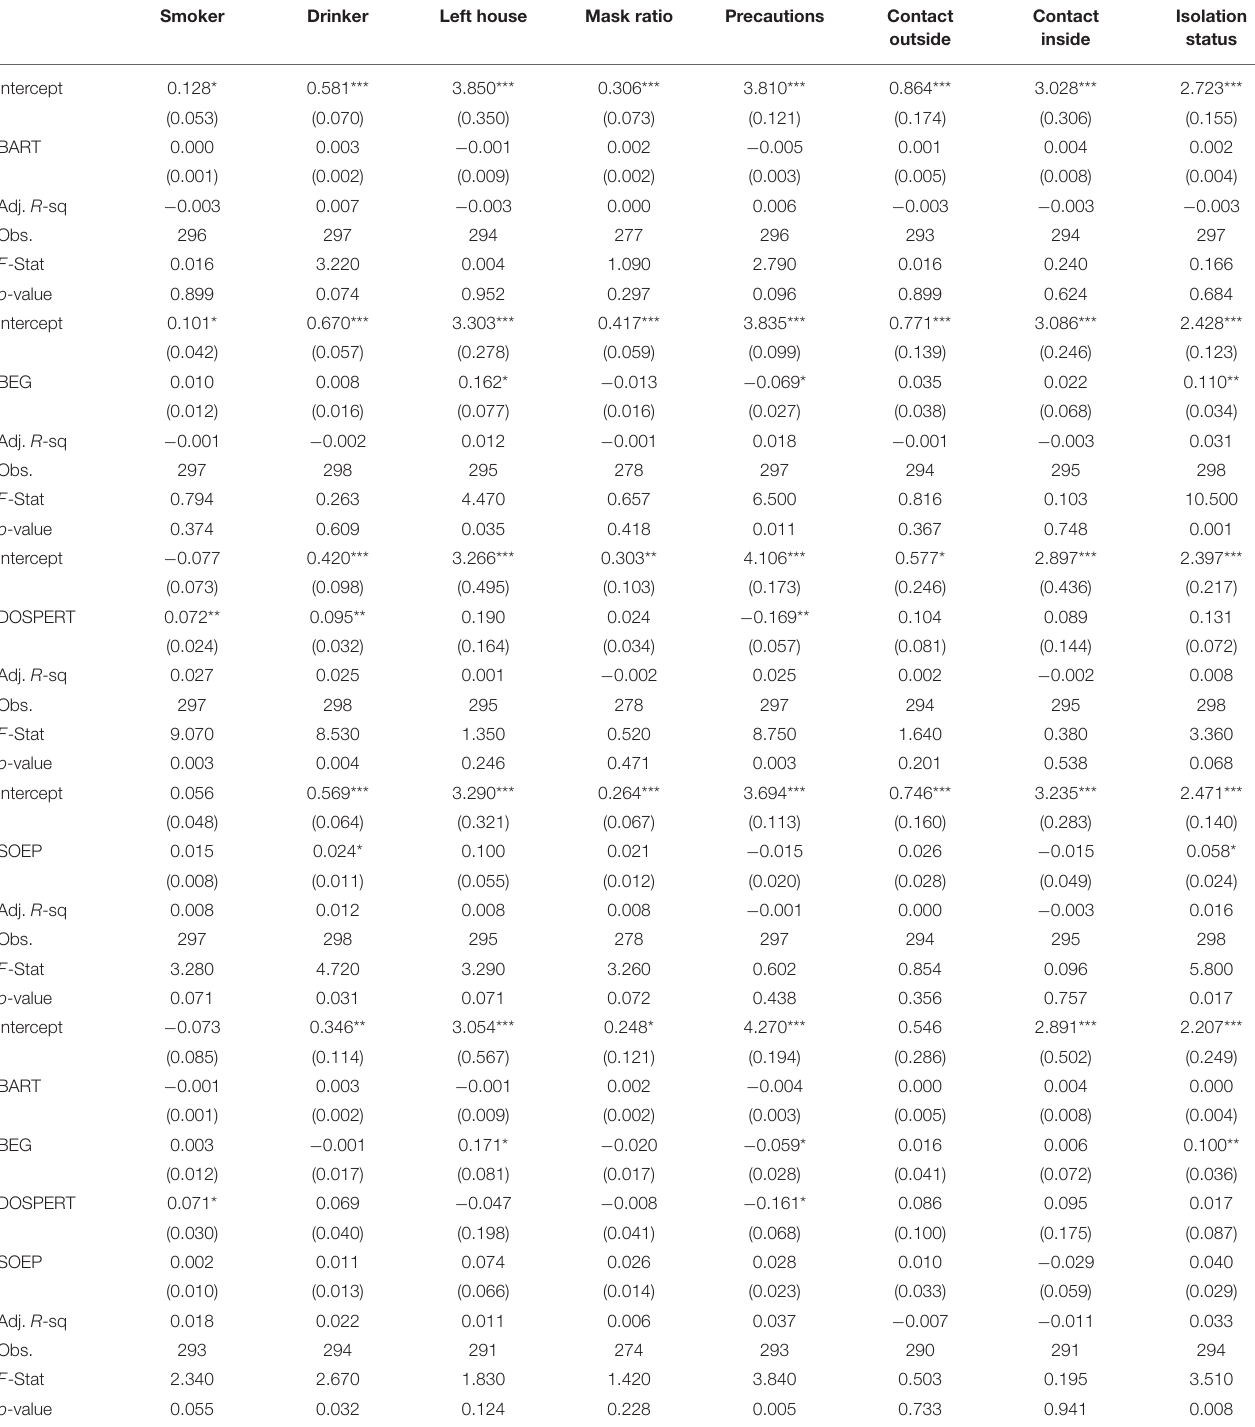
TABLE 6 | Linear regression analysis—self-reported real-world risky behaviors for study 2 (UK representative sample) regressed on the individual risk measures. Smoker Drinker Left house Mask ratio Precautions Contact